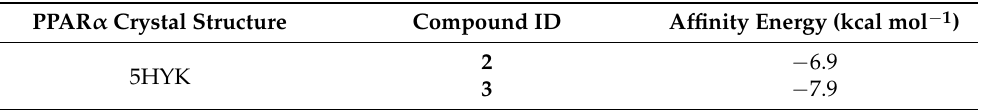
Table 2. In silico molecular docking binding affinities of compounds 2 and 3 to PPAR α crystal structure (PDB: